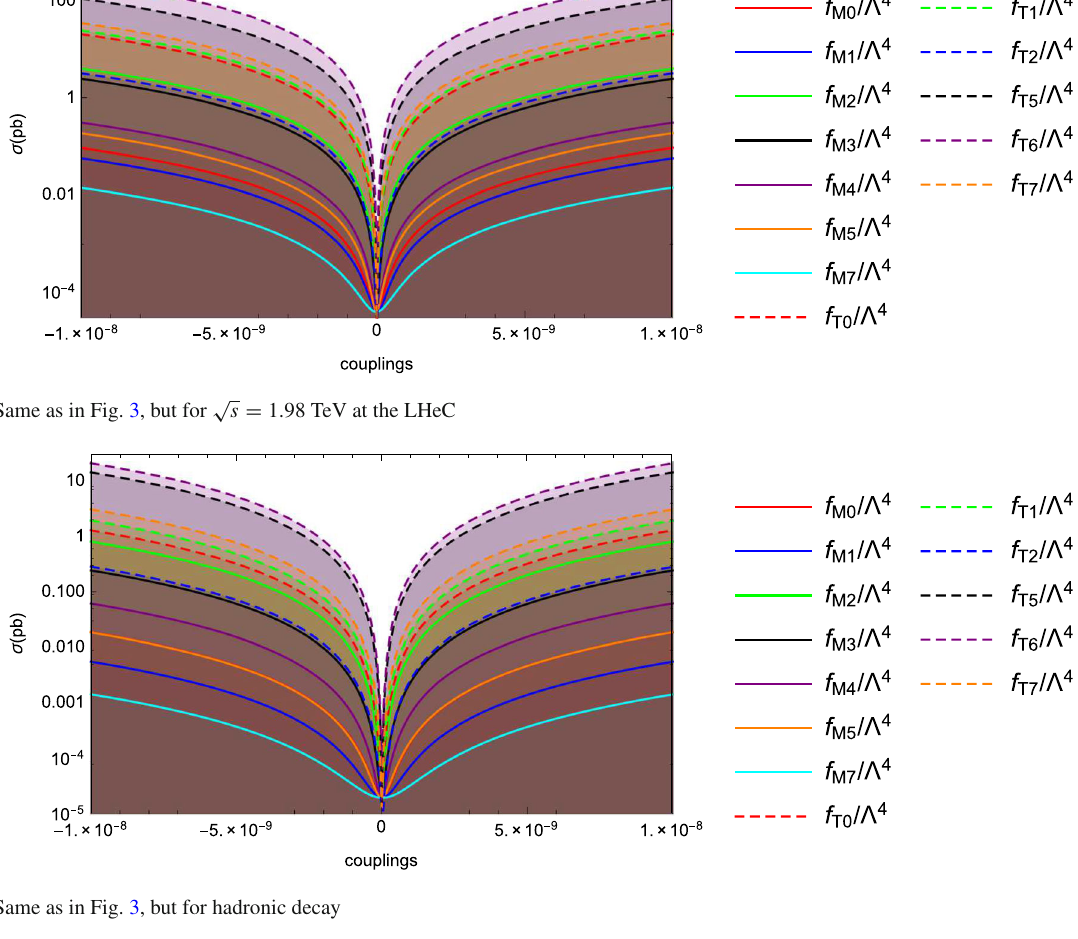
Fig. 5 Same as in Fig. 3, but for hadronic